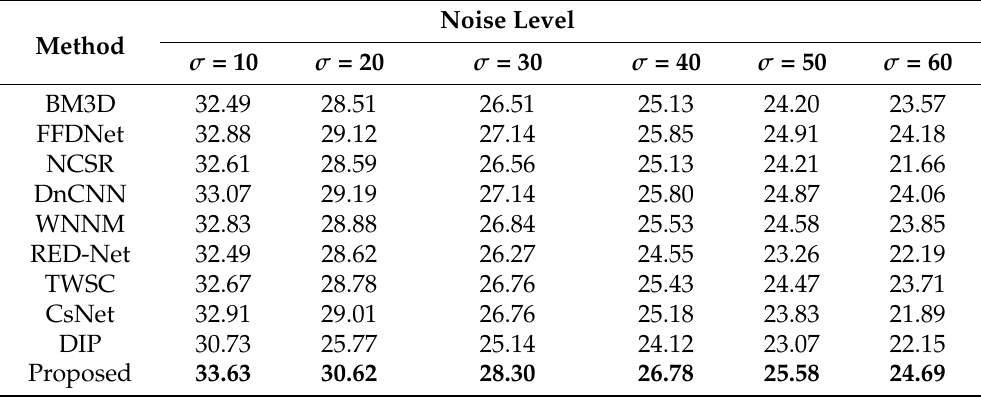
Table 12. Average PSNR results of different methods on 10 images in Flickr1024 with various noise levels.